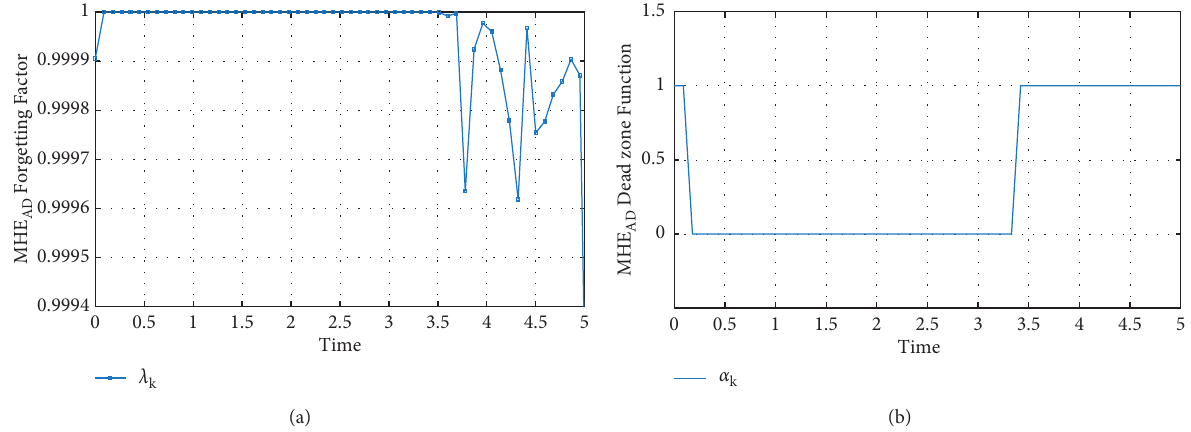
Figure 7: Evolution of the sequence of (a) forgetting factor ( λ